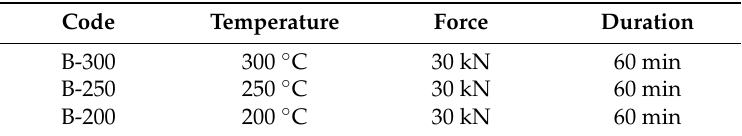
Table 2. Bonding conditions of Cu-Cu thermo-compression bonding.